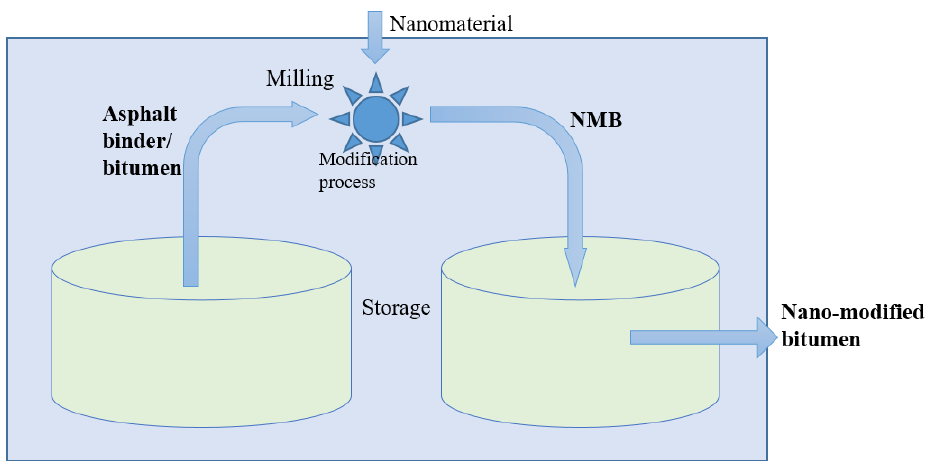
Figure 2. Nano-modified bitumen (NMB) production. 180